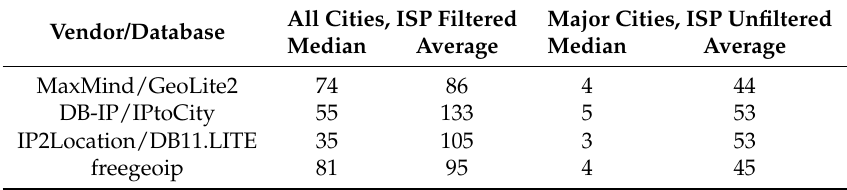
Table 7. Differences in location accuracy between ground truth covering all cities and ground truth with major